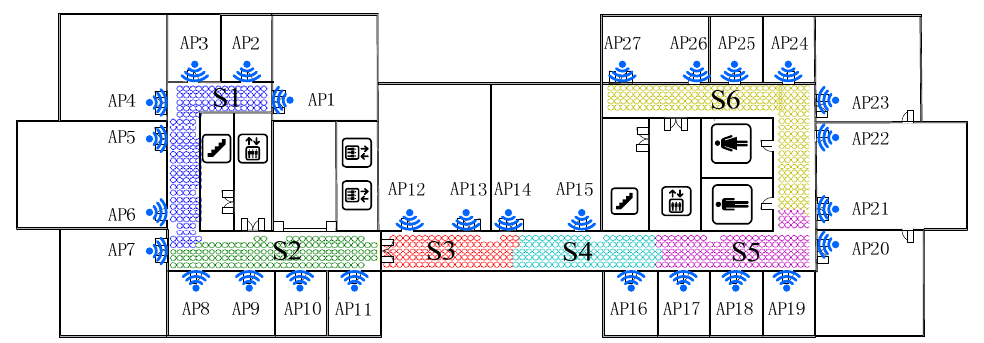
Figure 7. Positioning area clustered by the SDC